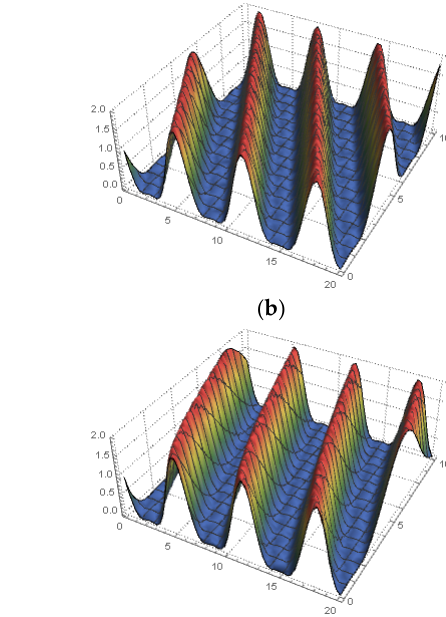
Figure 1. The 3D plots of | F 1 ( x , t ) | 2 and | G 1 ( x , t ) | 2 with the parameters r 1 = r 2 = 1, k 1 = k 2 = 1, q 0 = 0.6, p 2 = − 2, q 3 = 0.8, ρ = 1 and τ = 0 for various α values: ( a ) | F 1 | 2 , α = 1, ( b ) | G 1 | 2 , α = 1,